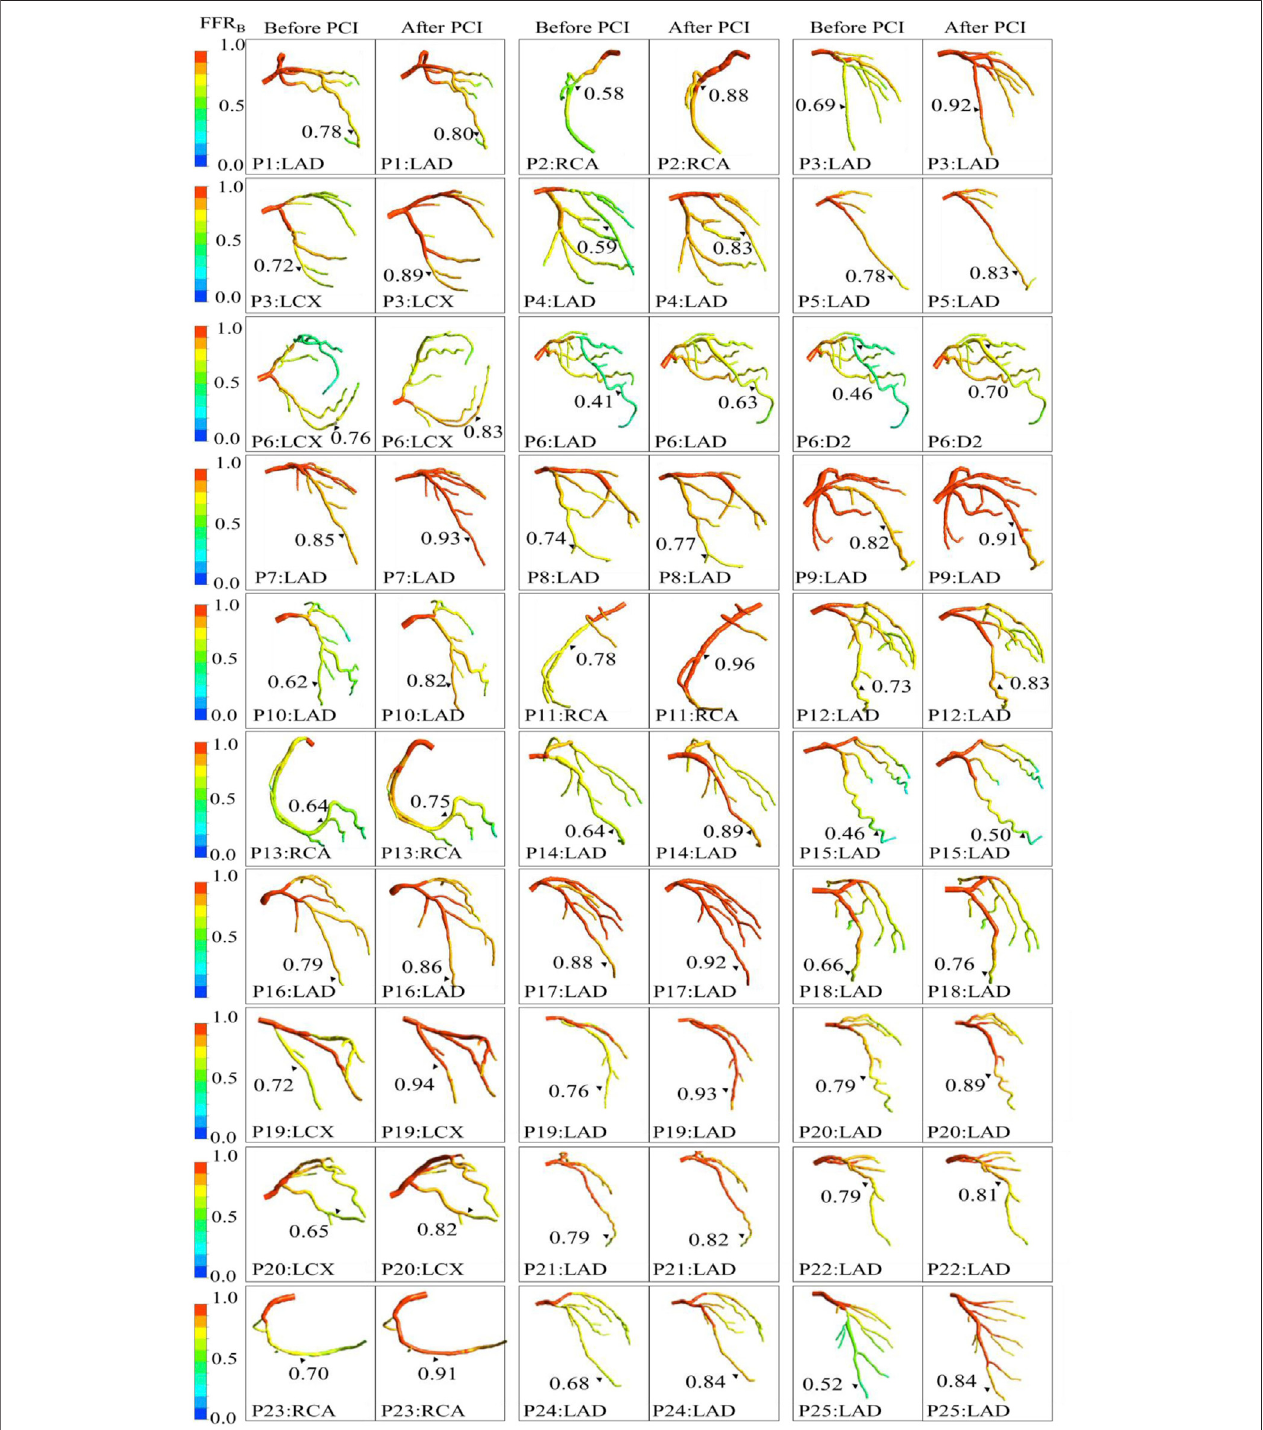
FIGURE 5 | Comparison of computationally simulated FFR (FFR B ) before and after stenting for all 25 patients (30 vessels).